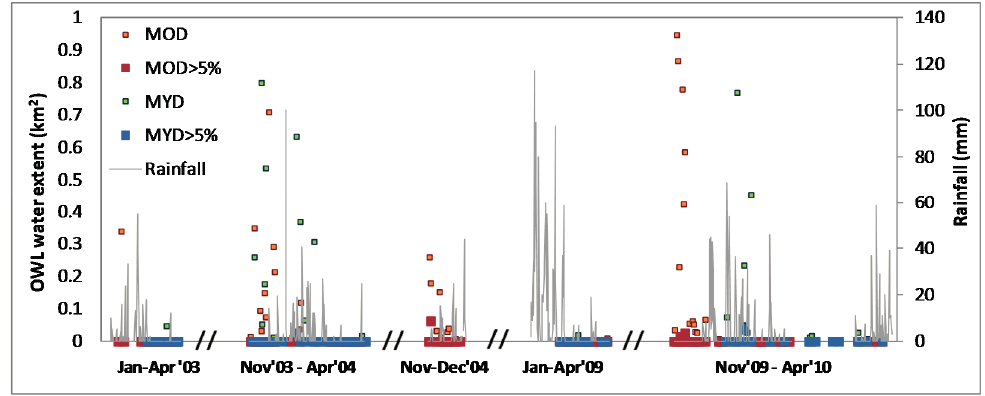
Figure 3. Total MODIS OWL flood extent for the MOD and MYD data for Site D1, for the 2003, 2004, 2009 and 2010 wet seasons. MODIS OWL flood extent using only those pixels mapping greater than 5% inundation is also shown, along with rainfall.